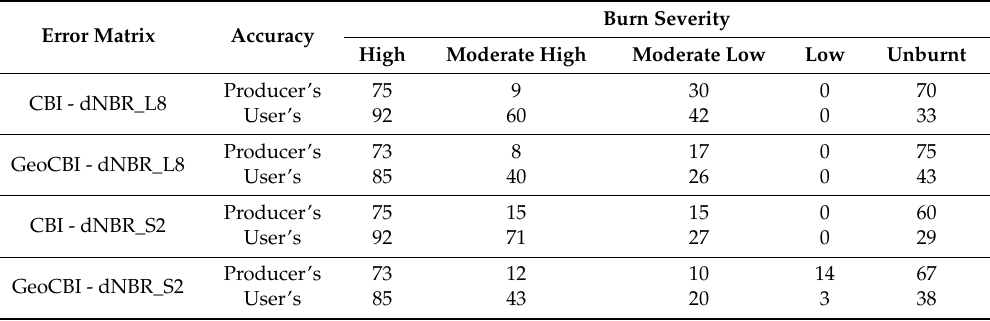
Table 2. Producer’s and User’s accuracy percentage values (PA and UA respectively) by burn severity categories and for each combination of the ground-based burn index (CBI and GeoCBI) and the See Table S1 for categories and ranges of the ground-based burn severity index, and Key and Benson (2006) for categories and ranges of dNBR